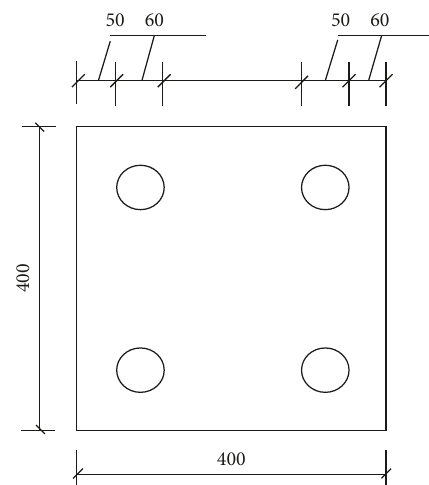
Figure 6: The cushion cap and pile